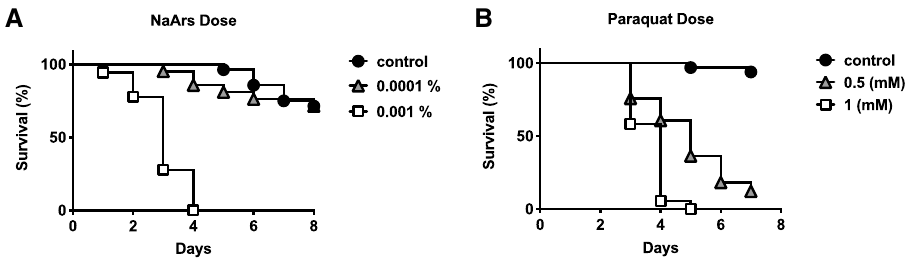
Figure 5. Oxidative stress mediated by NaArs or Paraquat ingestion reduces honey bee survival. ( A ) Survival of individual honey bees fed sugar solution containing 0 (n = 28), 0.001% (n = 18) or 0.0001% (n = 21) NaArs. Log- rank (Mantel-Cox) test showed that the curves are different (Chi square = 71.83, df = 2, < 0.0001). ( B ) Survival of individual honey bees fed sugar solution containing 0 (n = 33), 1 mM (n = 36), or 0.1 mM (n = 33) paraquat. Log-rank (Mantel-Cox) test showed that the curves are different (Chi square = 90.79, df = 2, < 0.0001).